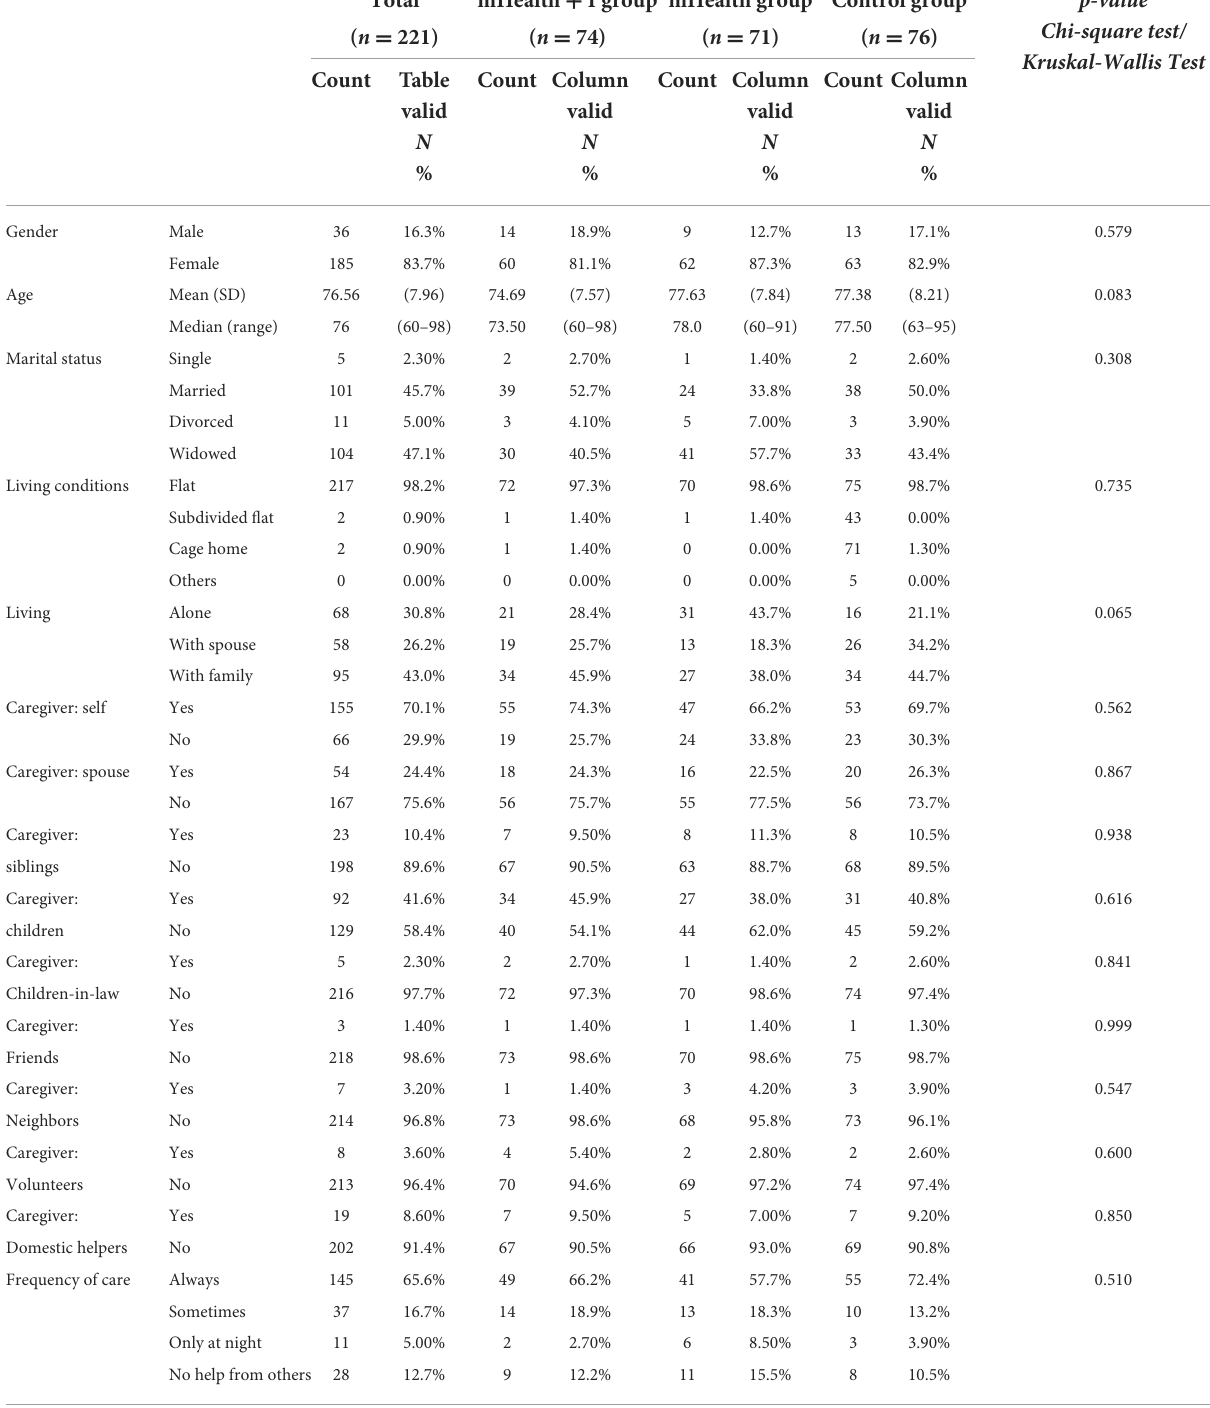
TABLE 1 Demographic characteristics of the